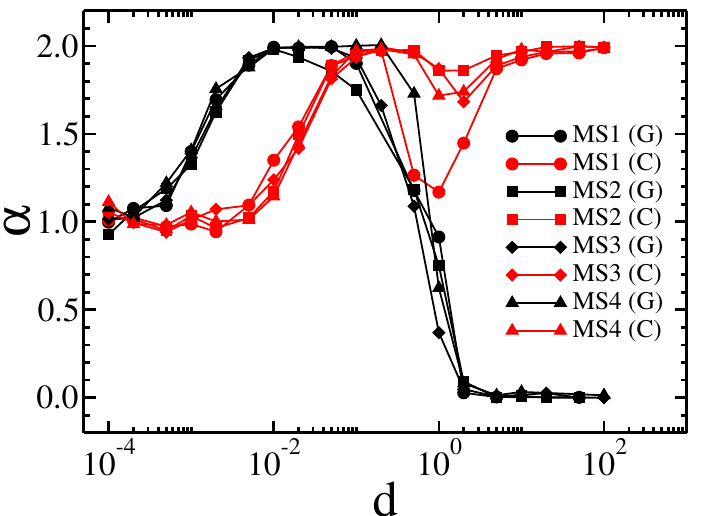
Figure 7. The dependence of the effective diffusion exponent α on the drift d for Gaussian random walks and Lévy flights on membranes MS1, MS2, MS3, and